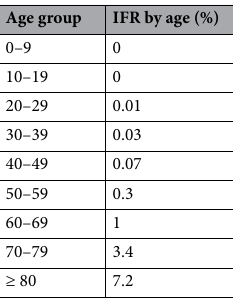
Table 4. IFR by age 62 .